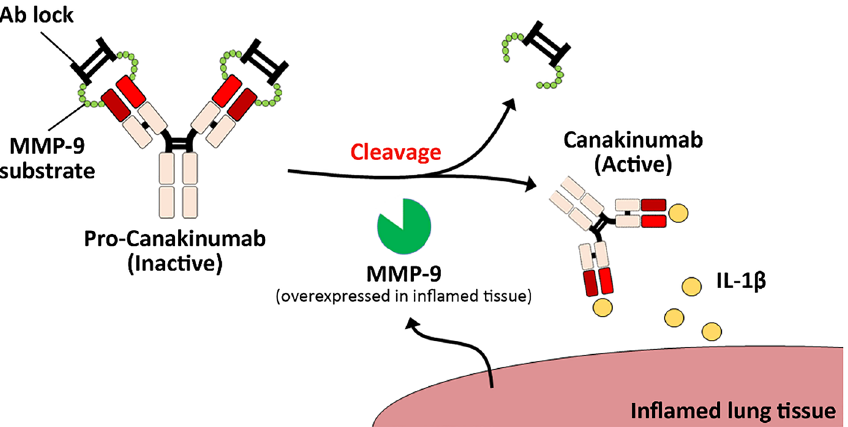
Figure 1. Schematic illustration of pro-Canakinumab selective activation by MMP-9 cleavage and specific neutralization of IL-1β at the inflamed region in autoinflammatory diseases. We engineered the human IgG1 hinge as an Ab lock (i.e. EPKSCDKTHTCPPCP) in front of the antigen-binding site of Canakinumab (fully human anti-human IL-1β mAb) by using MMP-9 substrate peptide as linker to generate pro-Canakinumab. After the Ab lock is removed by the MMP-9 expressed in the disease region, the cleaved pro-Canakinumab is expected to be specifically activated, neutralize the local IL-1β antigen and reduce the systemic on-target toxicity during autoinflammatory disease